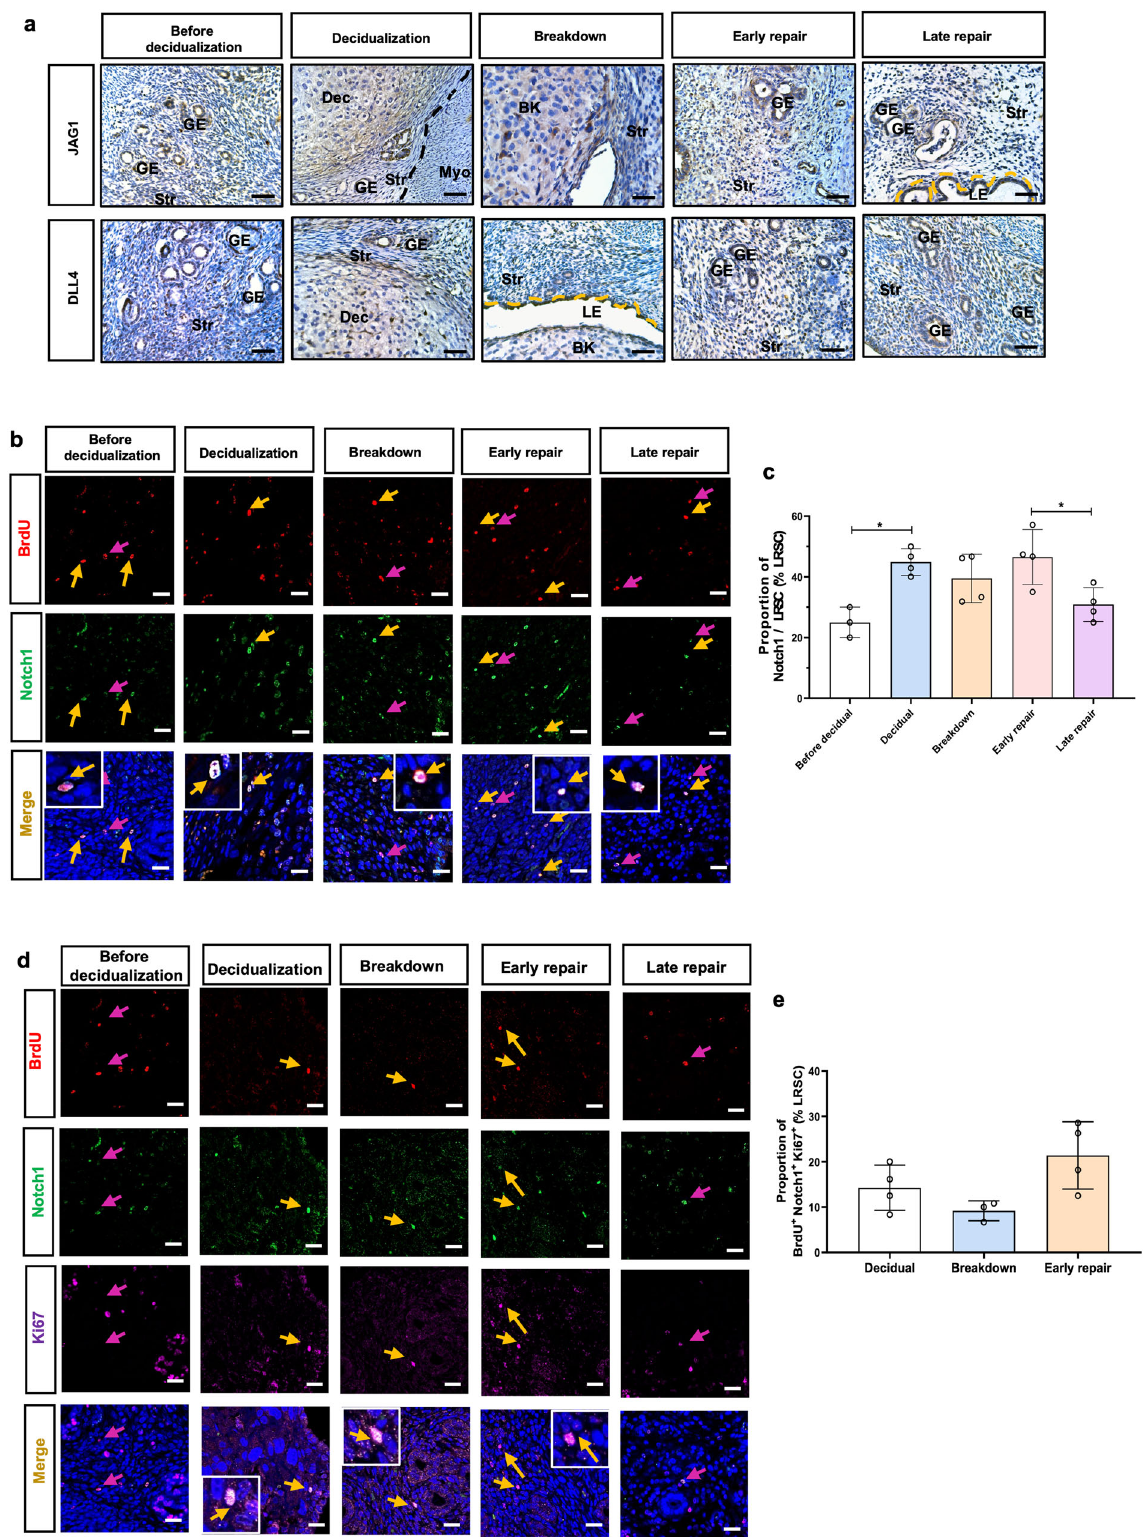
repair at the time of shedding. Findings in the human endome- trium support this observation, whereby endometrial regenera- tion occurs simultaneously with tissue breakdown in a piecemeal fashion 43,44 . The proportion of LRSC in our mouse menstrual- like model was similar to that reported by Kaitu ’ u-Lino et al. 42 .